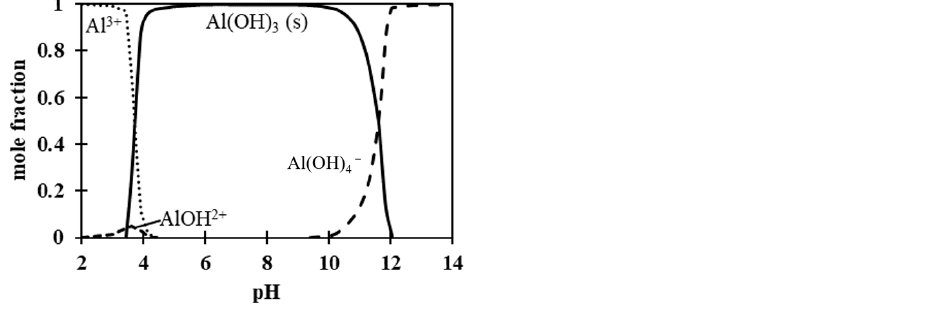
Figure A2. Dependences of Al(III) forms on the pH value of the aqueous solutions (c 0 = 2 mmol dm − 3 ).